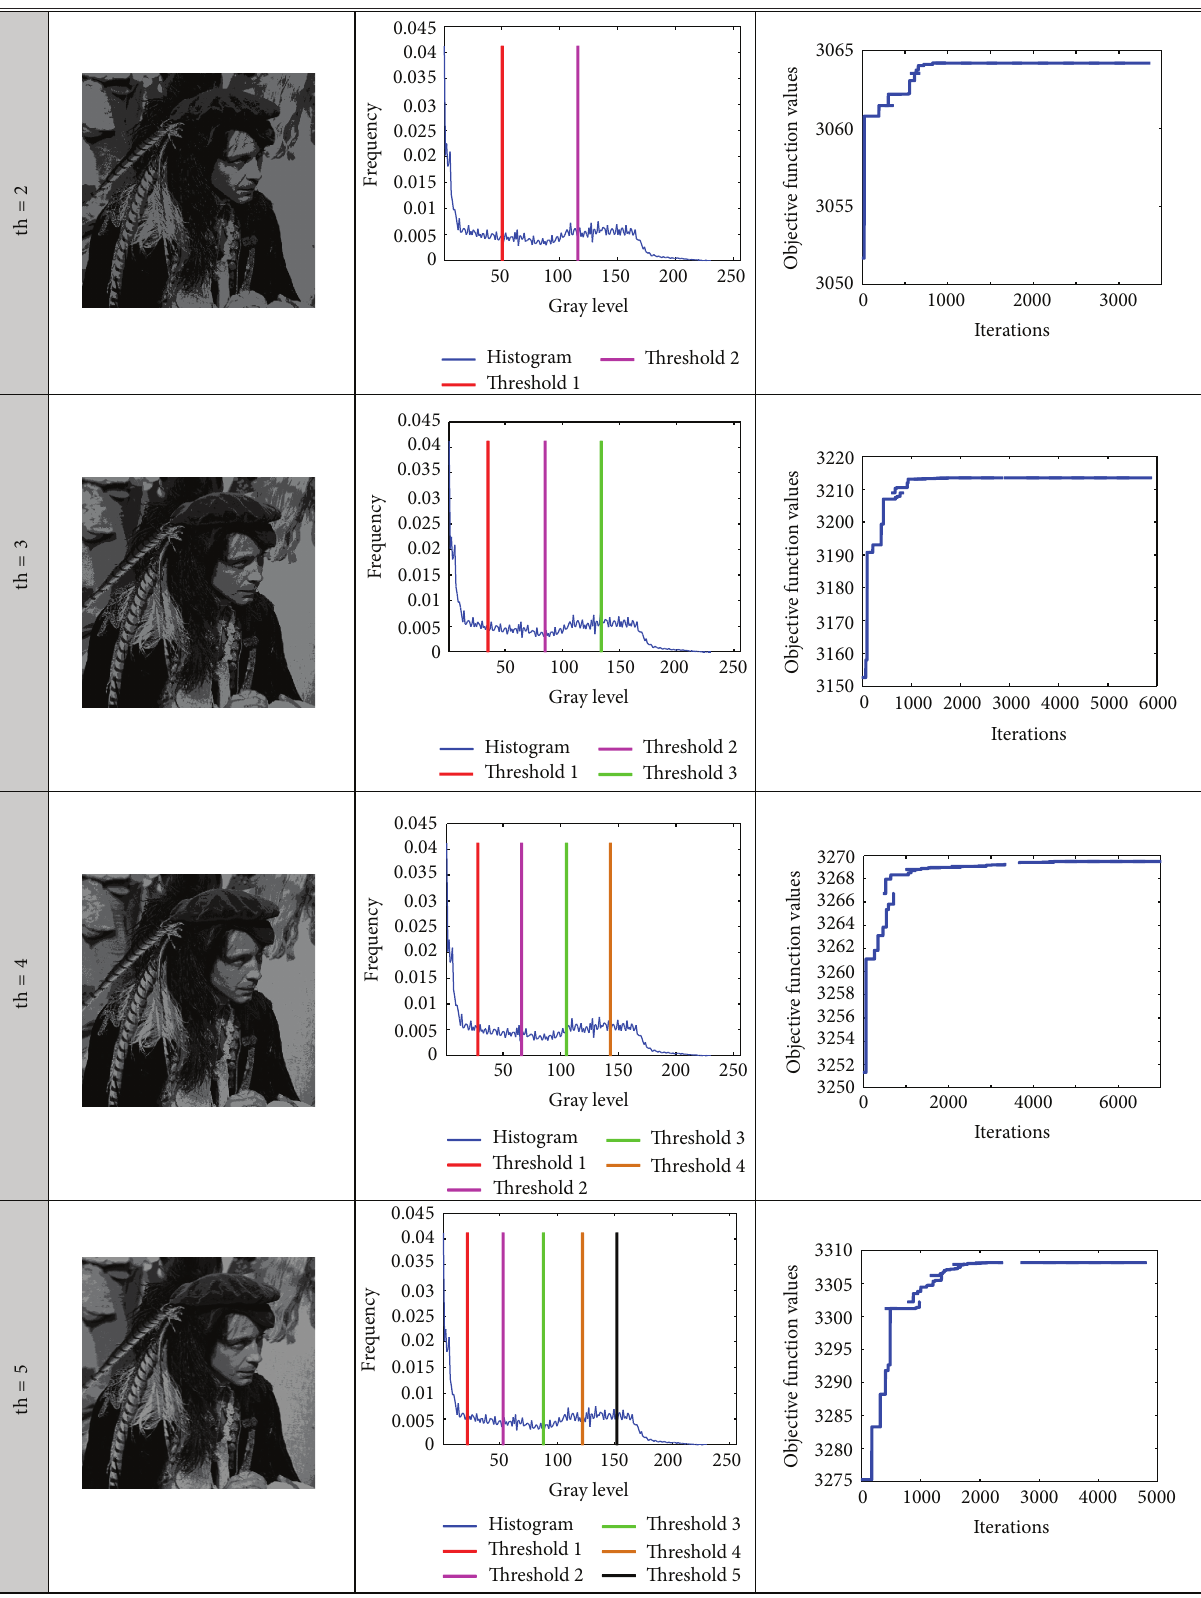
Table 7: Results after appling the HSMA using Otsu’s over the Hunter